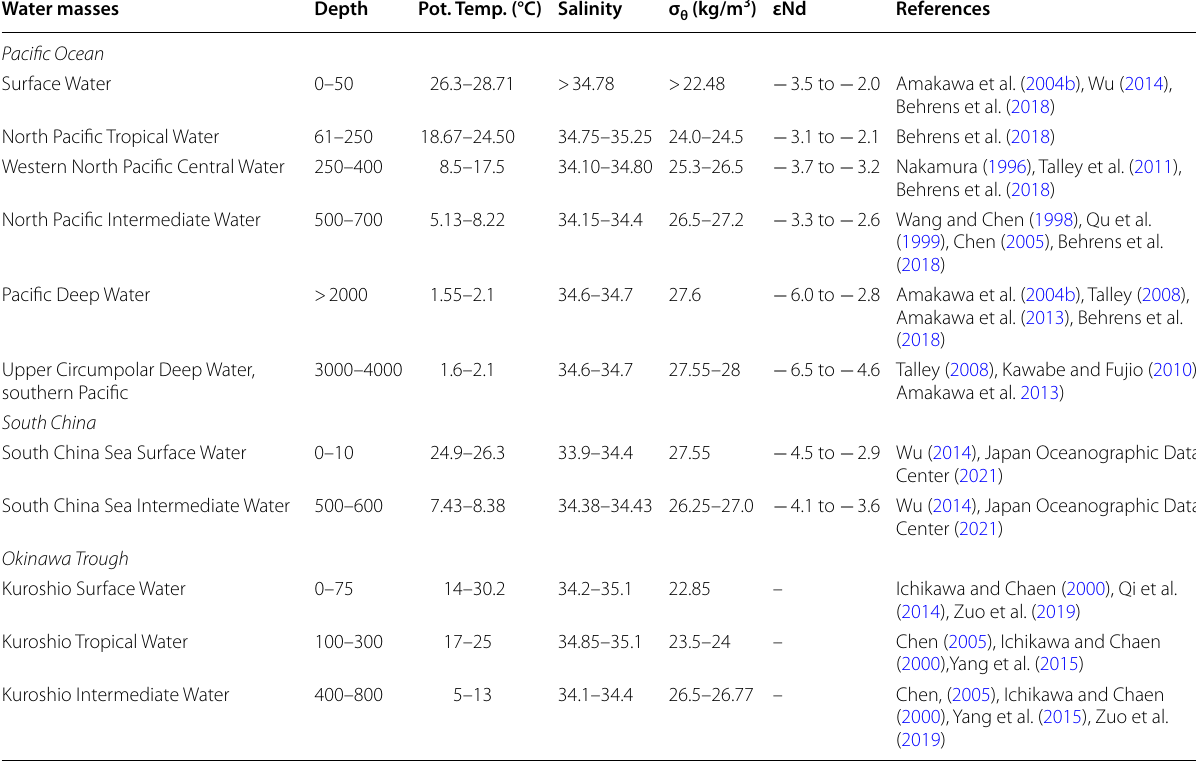
Table 2 Water masses previously reported from the Okinawa Trough and the Pacific